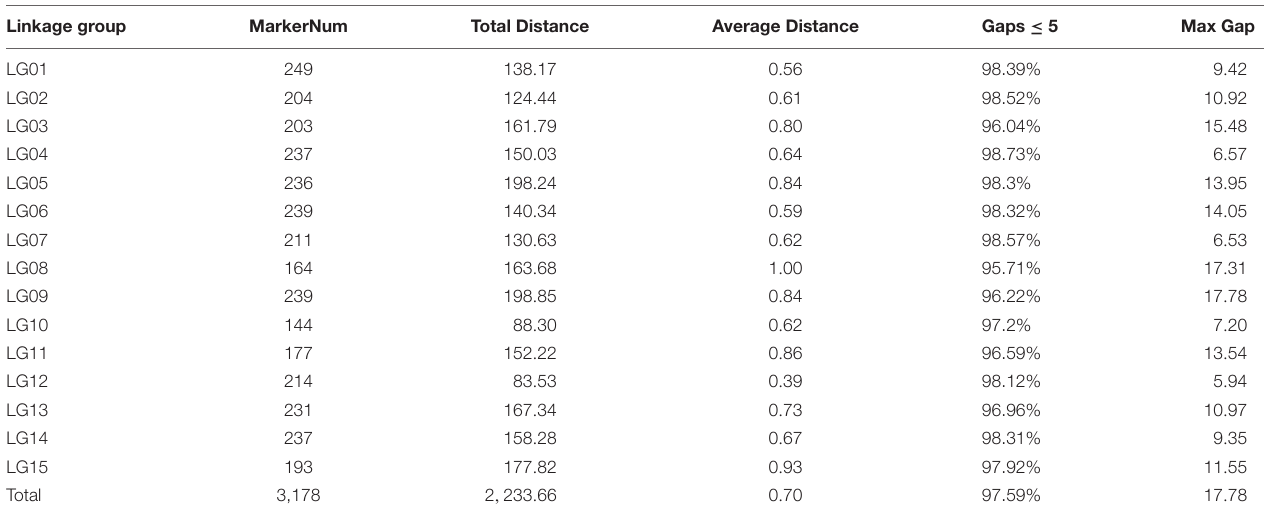
FIGURE 3 | Number of polymorphic SNPs for eight segregation patterns. The x-axis indicates eight segregation patterns of polymorphic SNPs markers; the y-axis indicates the number of markers. SNPs, single nucleotide polymorphisms. TABLE 3 | Summary of the 15 linkage groups of integrated sweet potato